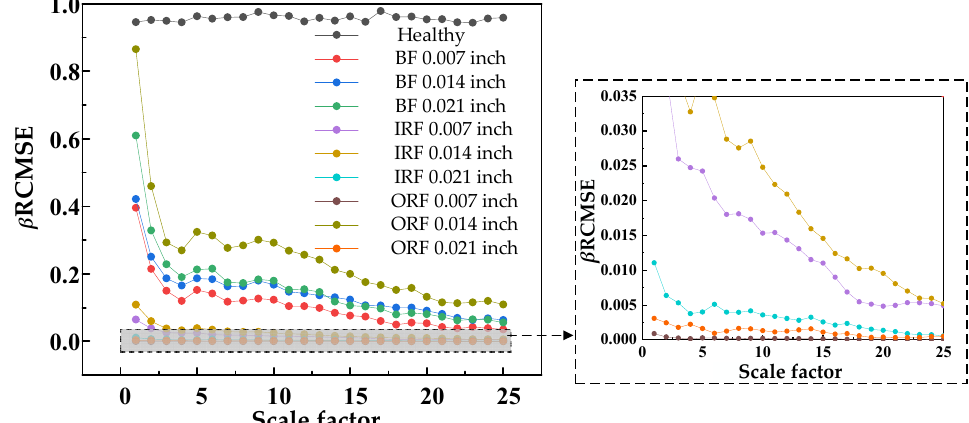
Figure 10. β RCMSE entropy values of 25 scale factors under different damage degrees.